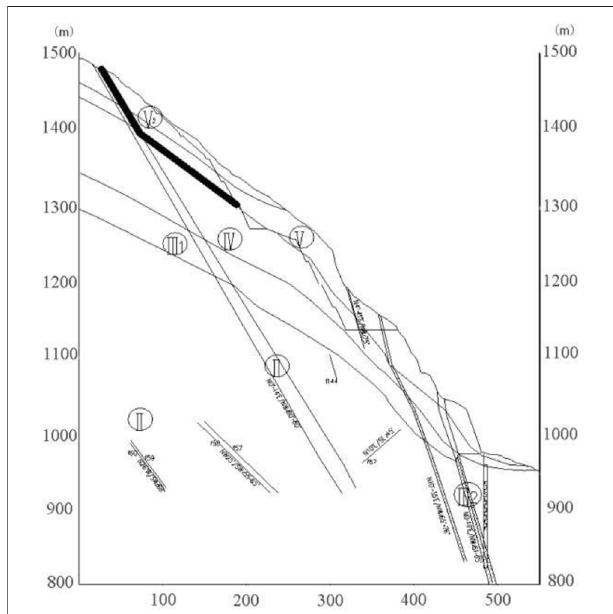
FIGURE 8 | Schematic of the dangerous slip